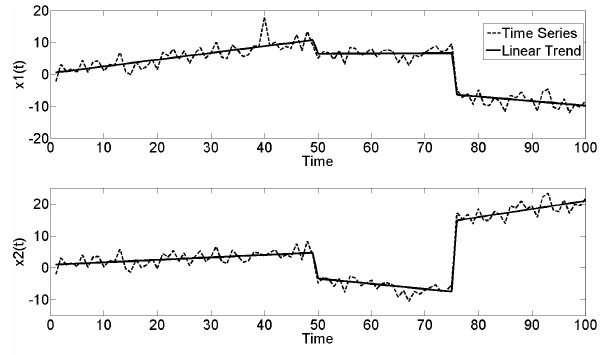
Figure 2. Cluster membership functions for synthetic data when K = 3 and δ = 1. It can be seen that the clusters are found correctly.